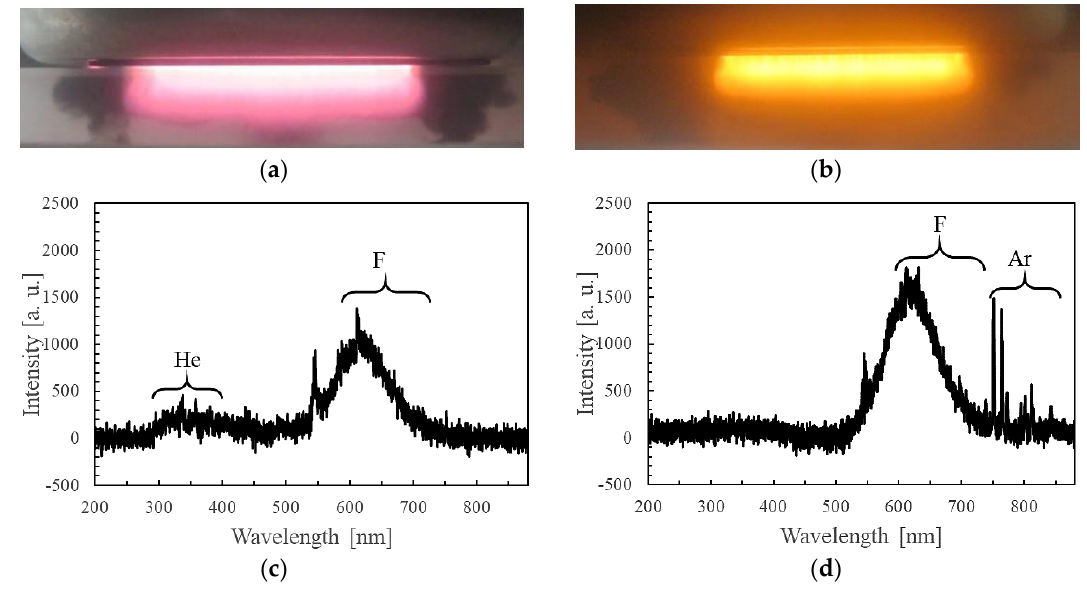
Figure 2. Photographs and light-emission spectra of surface-discharge plasma using optical-emission